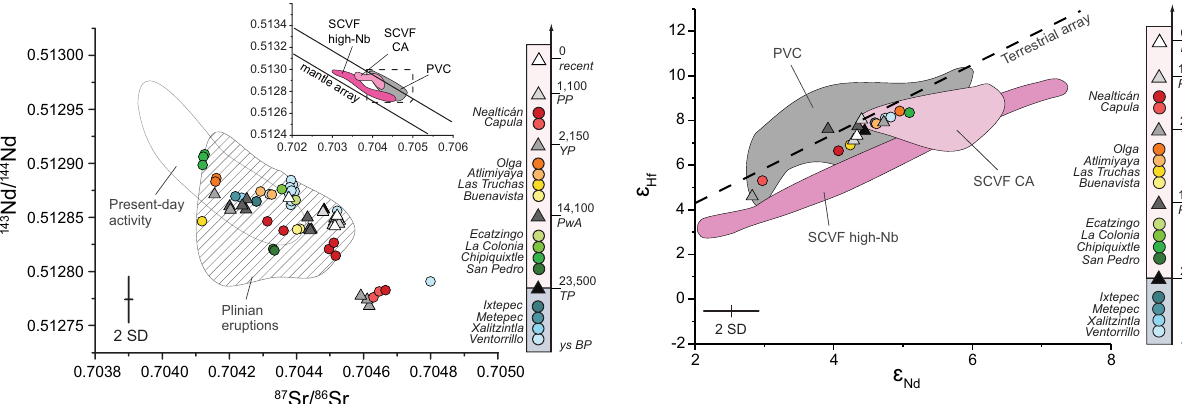
Figure 6: ε Hf vs. ε Nd of selected Ventorrillo and Popocatépetl lavas and pumices. Present-day terres- trial array from Vervoort et al. [2011], SCVF data from Straub et al. [2015], PVC data from Straub et al. [2015] and Cai et al.